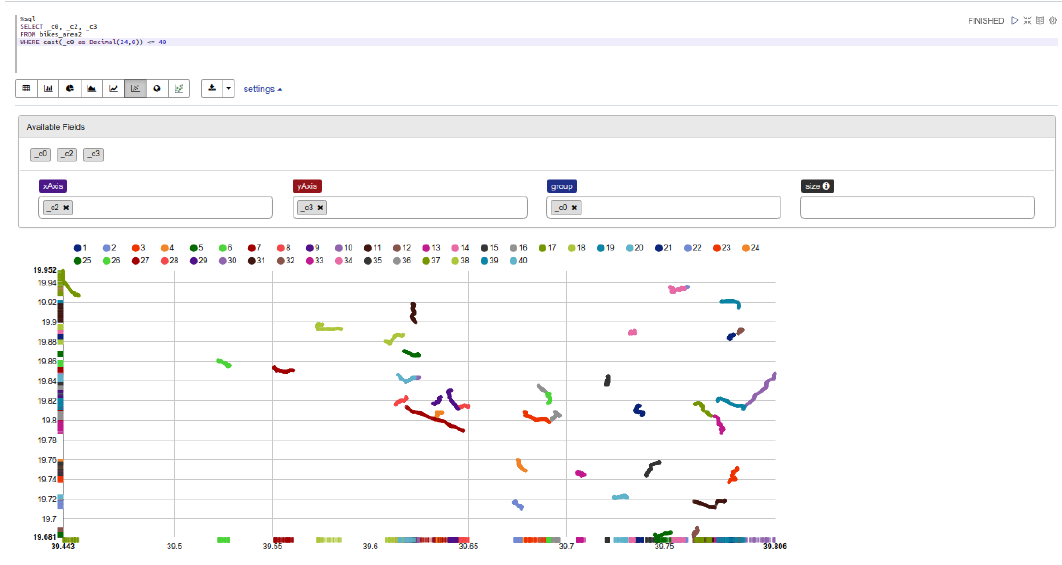
Figure 4. An Overview of 40 Trajectories through Zeppelin.